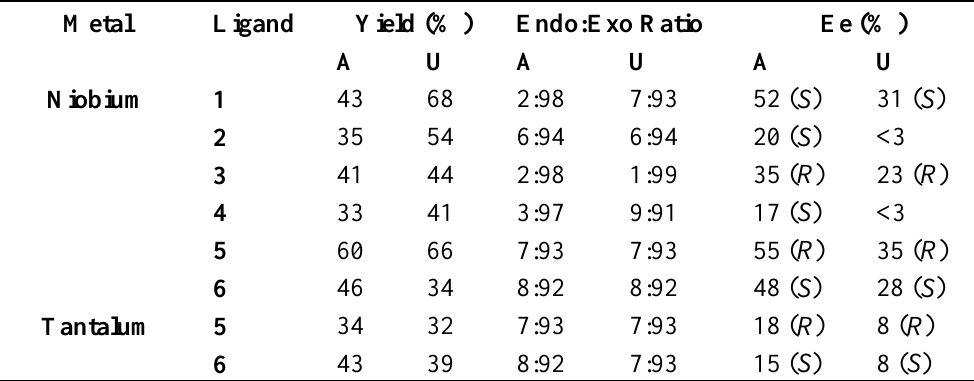
Table 3. Results using activated and unactivated